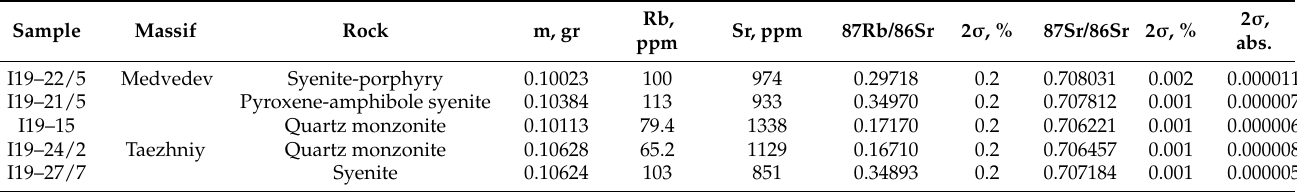
Table A5. Rb-Sr isotope analyzes the data of rocks of the Medvedev and Taezhniy massifs.